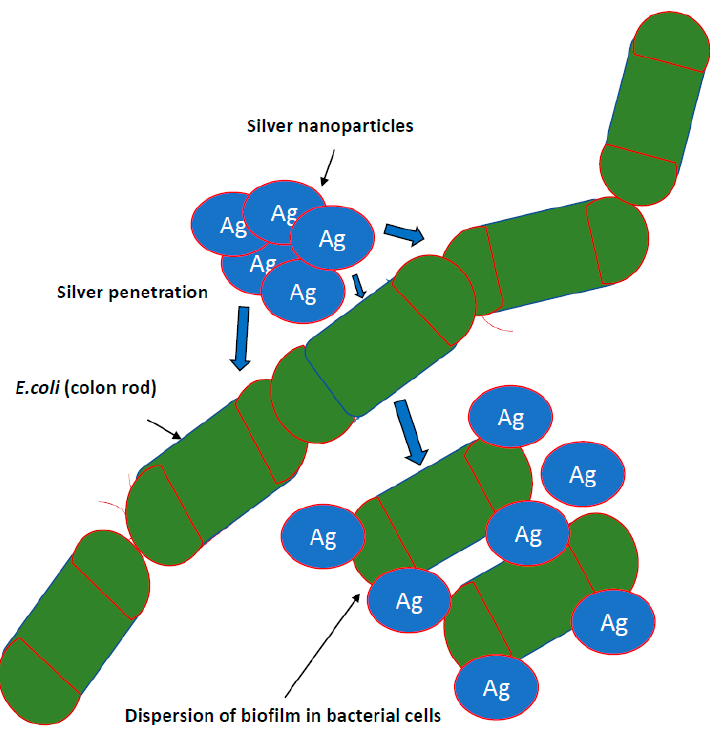
Figure 2. Inhibiting the growth of bacterial biofilms by nanoparticles. It is known that nanosilver efficiently prevents the formation and further stages of biofilm development; however, the effect depends on the species and even the bacterial strain. This effect is generally stronger against biofilm formed by Gram-negative pathogenic bacteria.